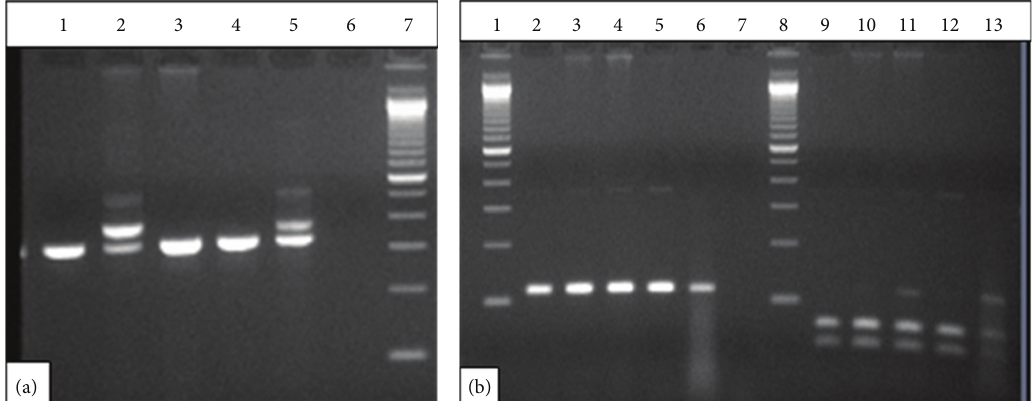
Figure 2: PCR analysis of FLT3 -ITD and D835 mutations. (a) This gel shows patients positive for ITD lanes 2 and 5, patients negative for ITD lanes 1, 3, and 4, water control lane 6, and marker lane 7. (b) This gel shows undigested sample for D835 lanes 2–6, water control lane 7, marker lanes 1 and 8, digested sample lanes 9–13, positive patients lanes 11 and 13, and negative patients lanes 9, 10, and